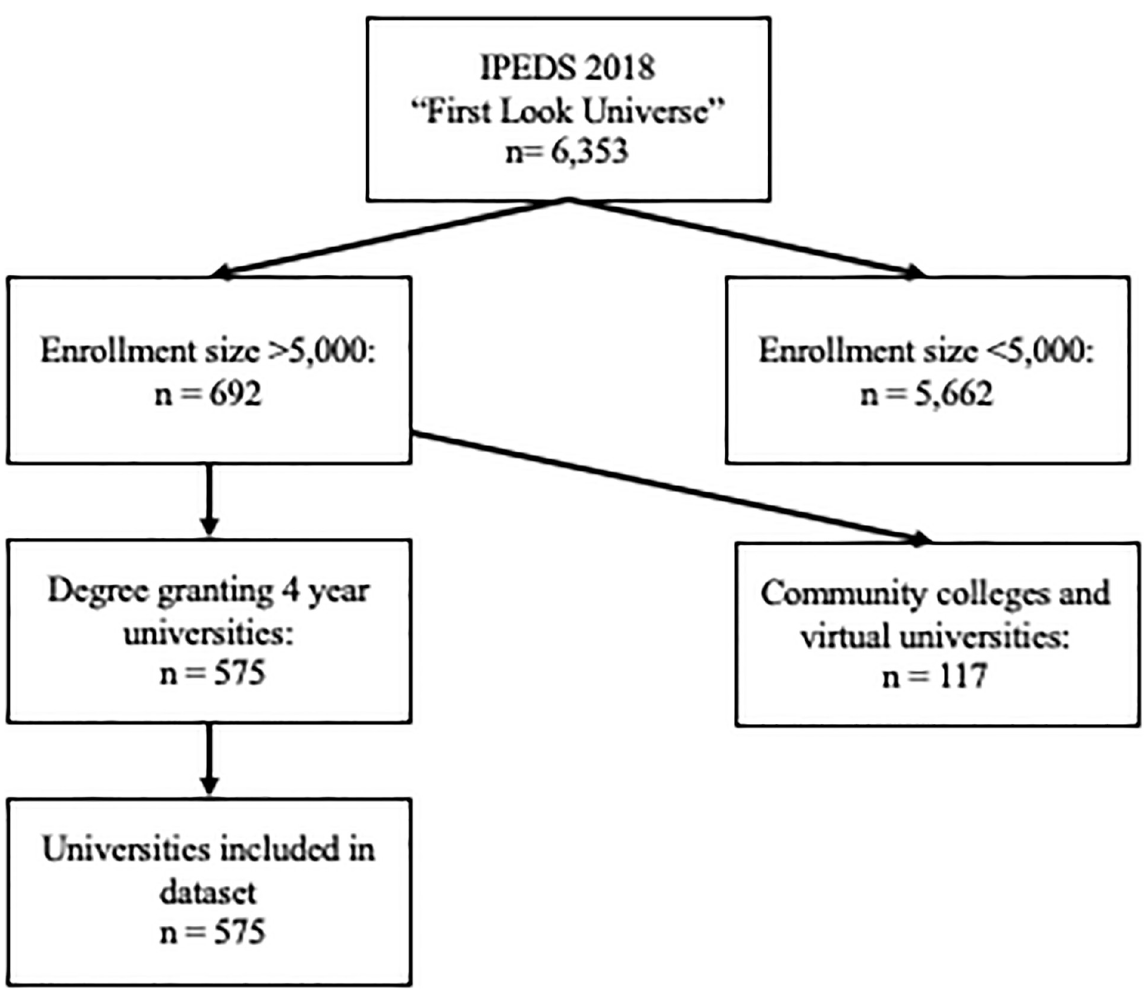
Fig 1. Flow chart depicting university inclusion and exclusion criteria for